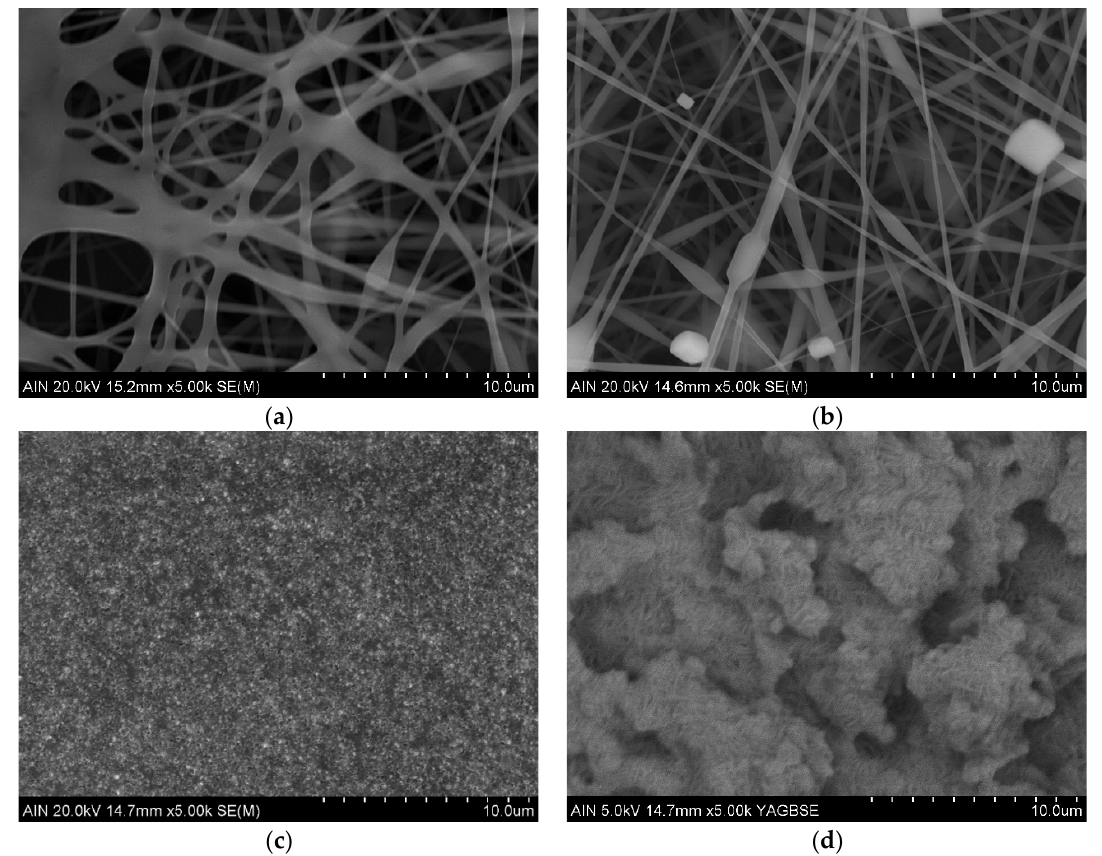
Figure 3. Field- emission scanning electron microscopy (FE-SEM) images of the samples surface morphology. S1 ( a ), S2 ( b ), S3, ( c ) and S4 ( d ) at the scale of 10 µm.